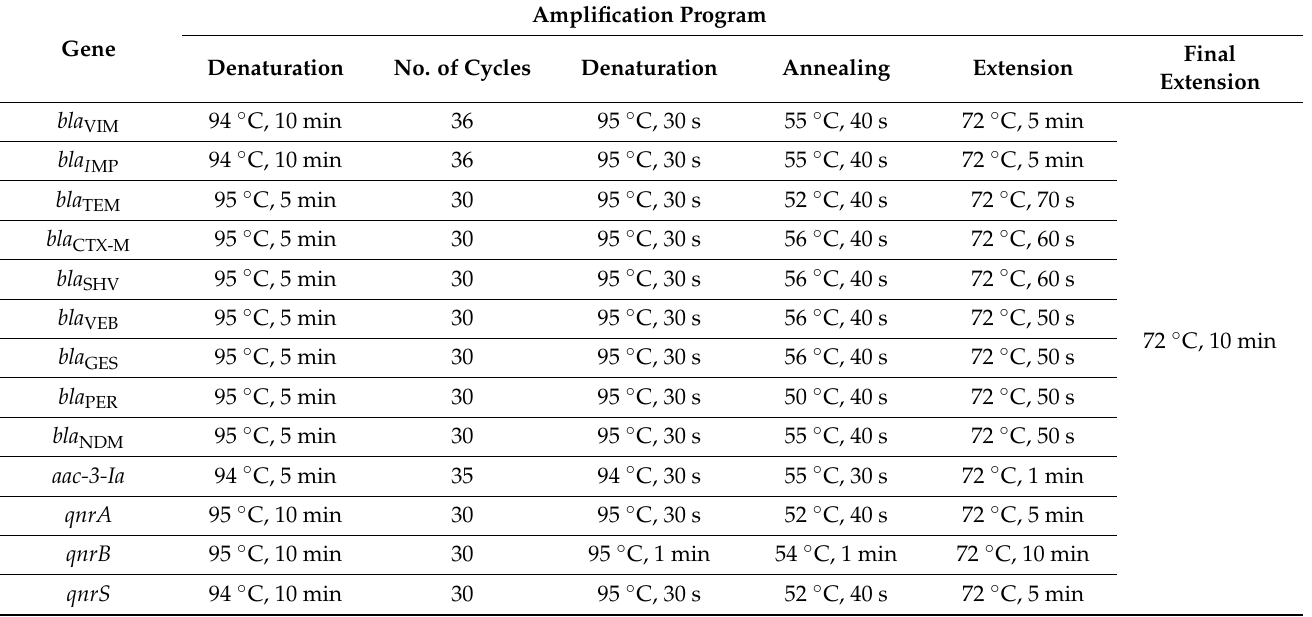
Table 5. Amplification program for antibiotic resistance